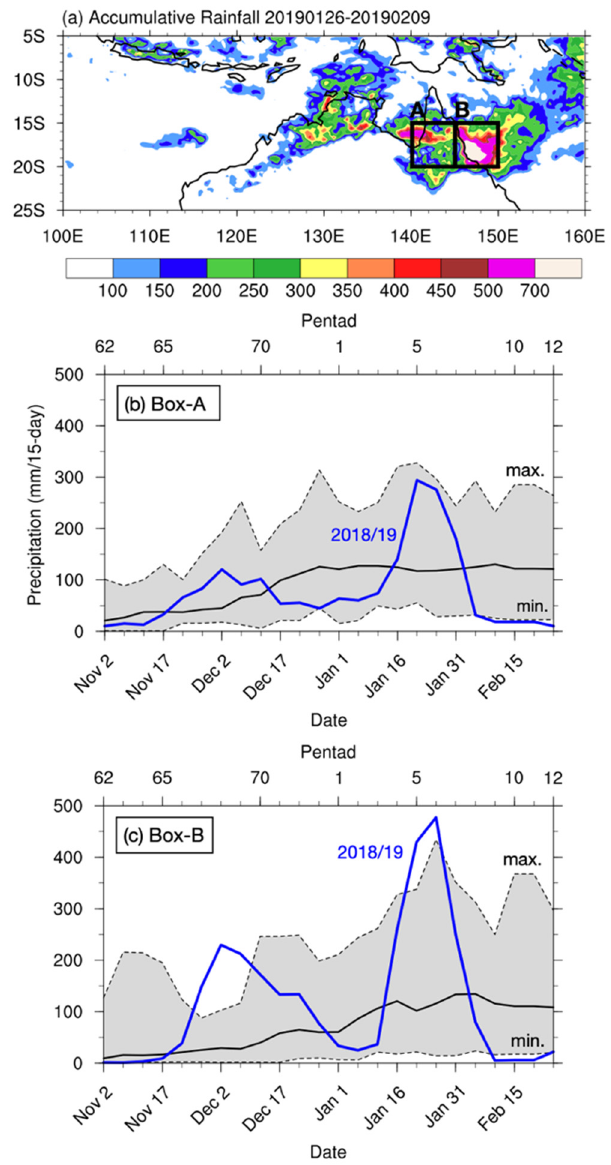
Figure 1. ( a ) The 15-day accumulative rainfall calculated using CMORPH precipitation data from 26 January to 9 February 2019, the northern Queensland flood. The black boxes, Box-A (140°~145° E, 15°~20° S) and Box-B (145°~150° E, 15°~20° S), represent northern Queensland and the marginal sea. ( b , c ) The area-mean 15-day accumulative rainfall time series running by pentad is calculated using CMORPH precipitation data over Box-A and Box-B, respectively. The date (the corresponding Julian pentad) marks the first day (pentad) of the 15-day period. The dashed lines represent the maximum and minimum rainfall derived by 1998 to 2017 climatology; the black solid line represents the climatological median. The blue line is the time series in summer 2018/19.